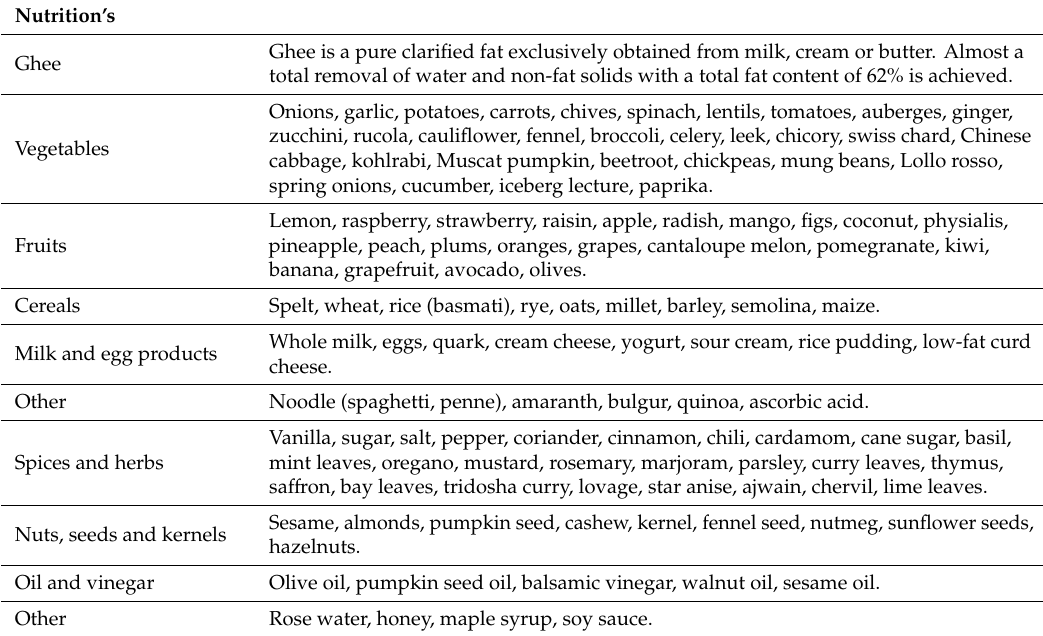
Table 3. Ingredients during the two-week diet which all patients with Parkinson’s disease (PD) have